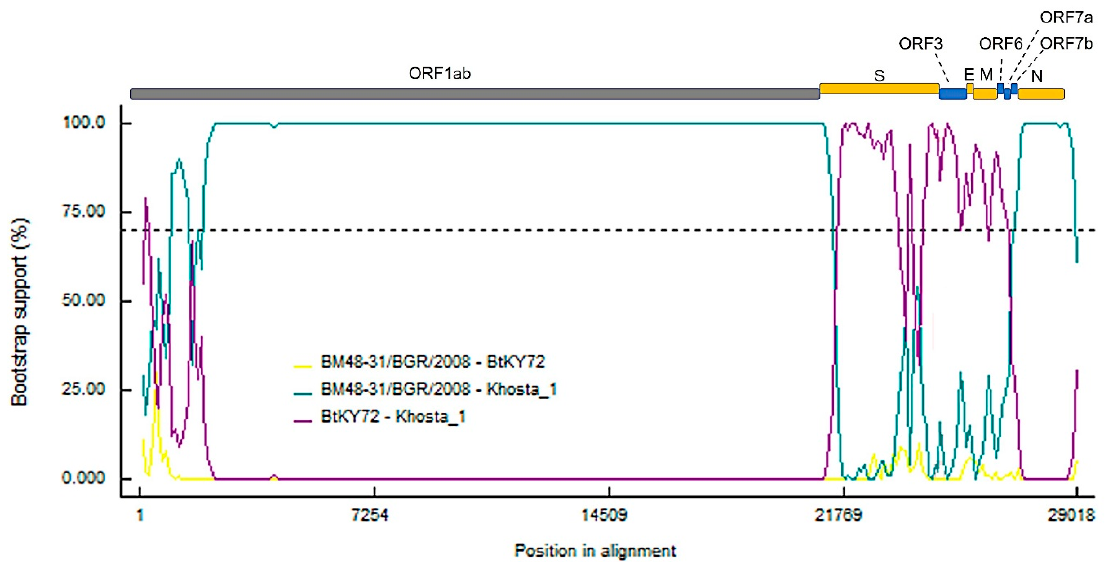
Figure 4. Results of bootscan analysis of recombination events in Khosta-1 genome using RDP5 software. The analysis was performed using the Jukes and Cantor (1969) model, with a window size of 1000 bases, a step size of 100 bases and a number of bootstrep replicates of 100 as implemented in RDP5 program. Cutoff percentage (70%) shown by dashed line. The colors of the lines correspond to different pairs of analyzed viruses as indicated in the legend.